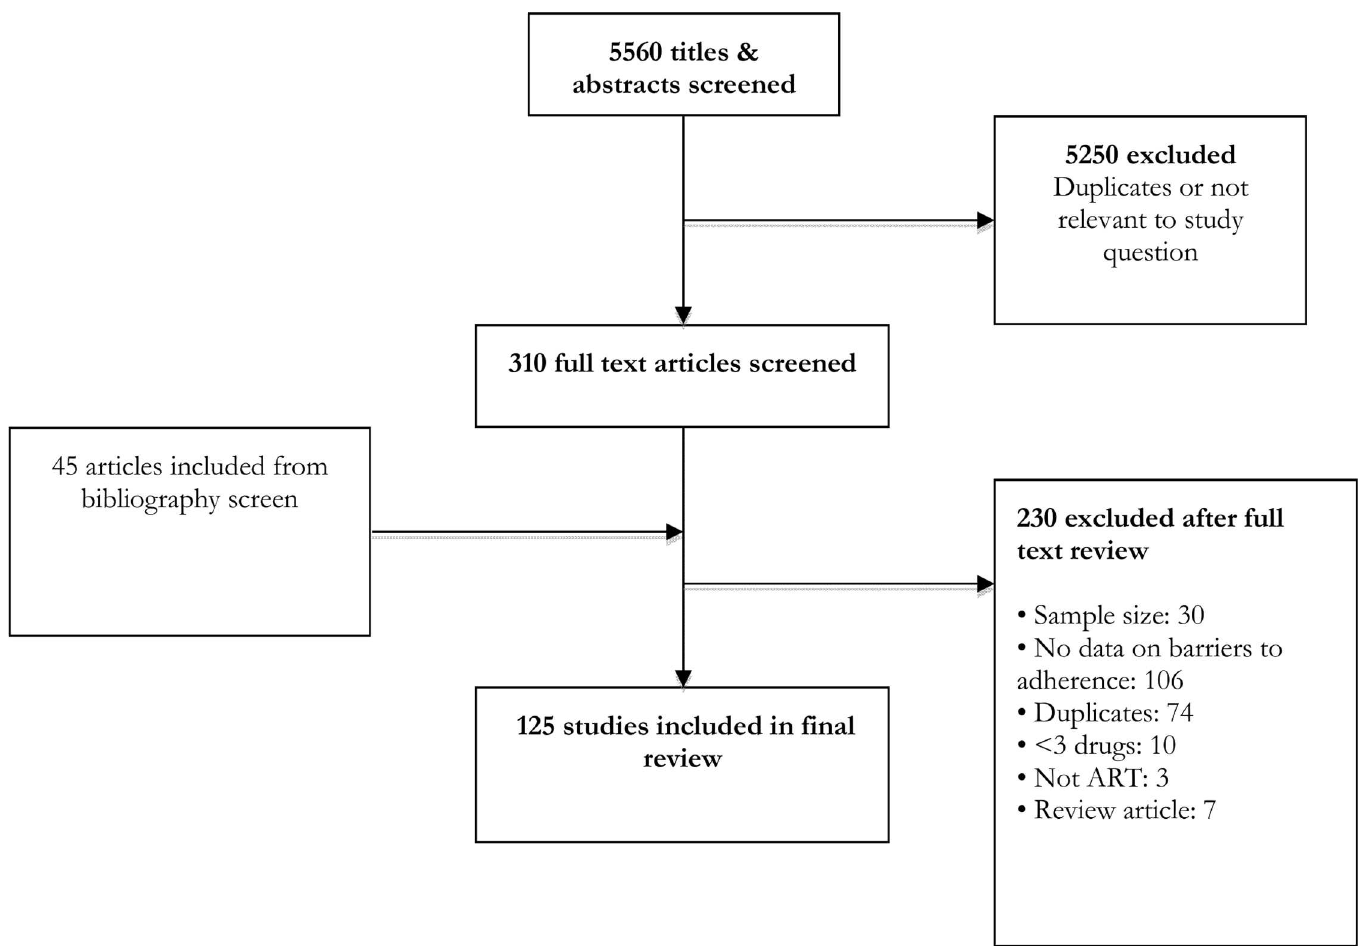
Fig 1. Study selection